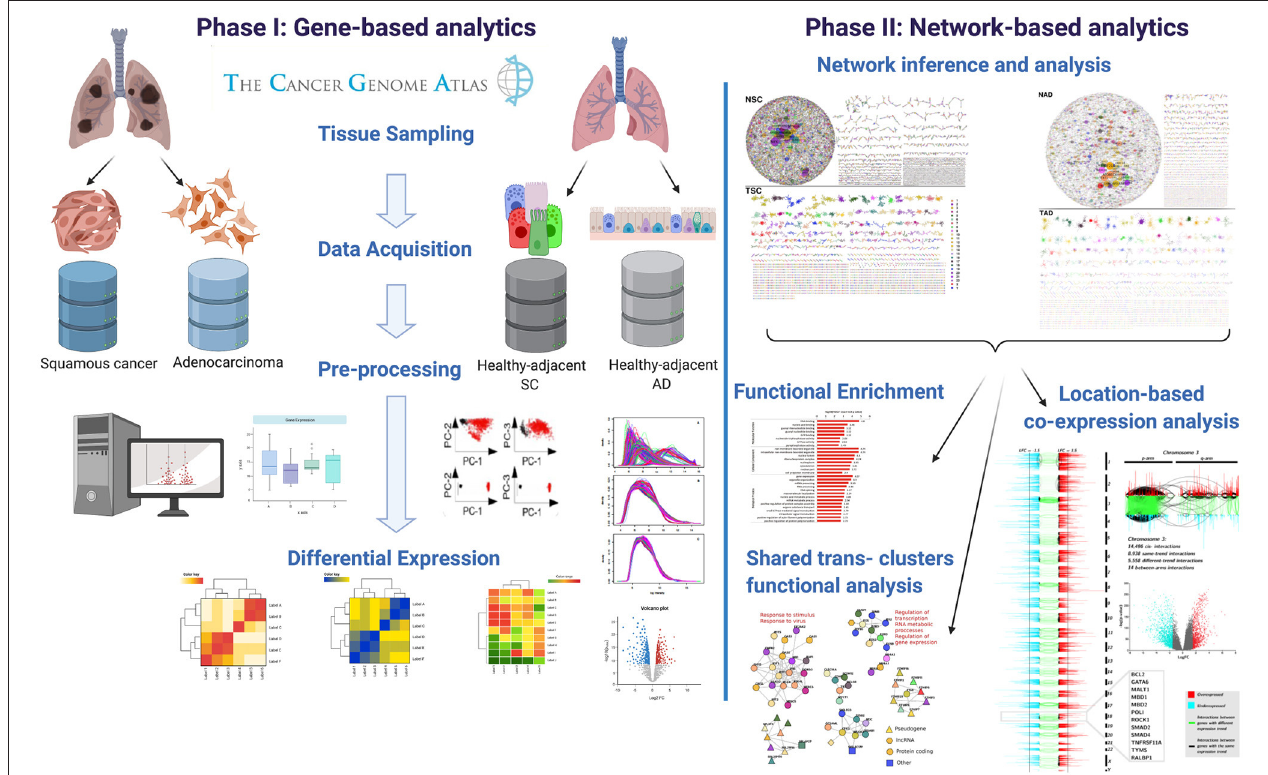
FIGURE 1 | Graphical pipeline followed in this work. In the figure, we show the main steps in which this methodology is divided.